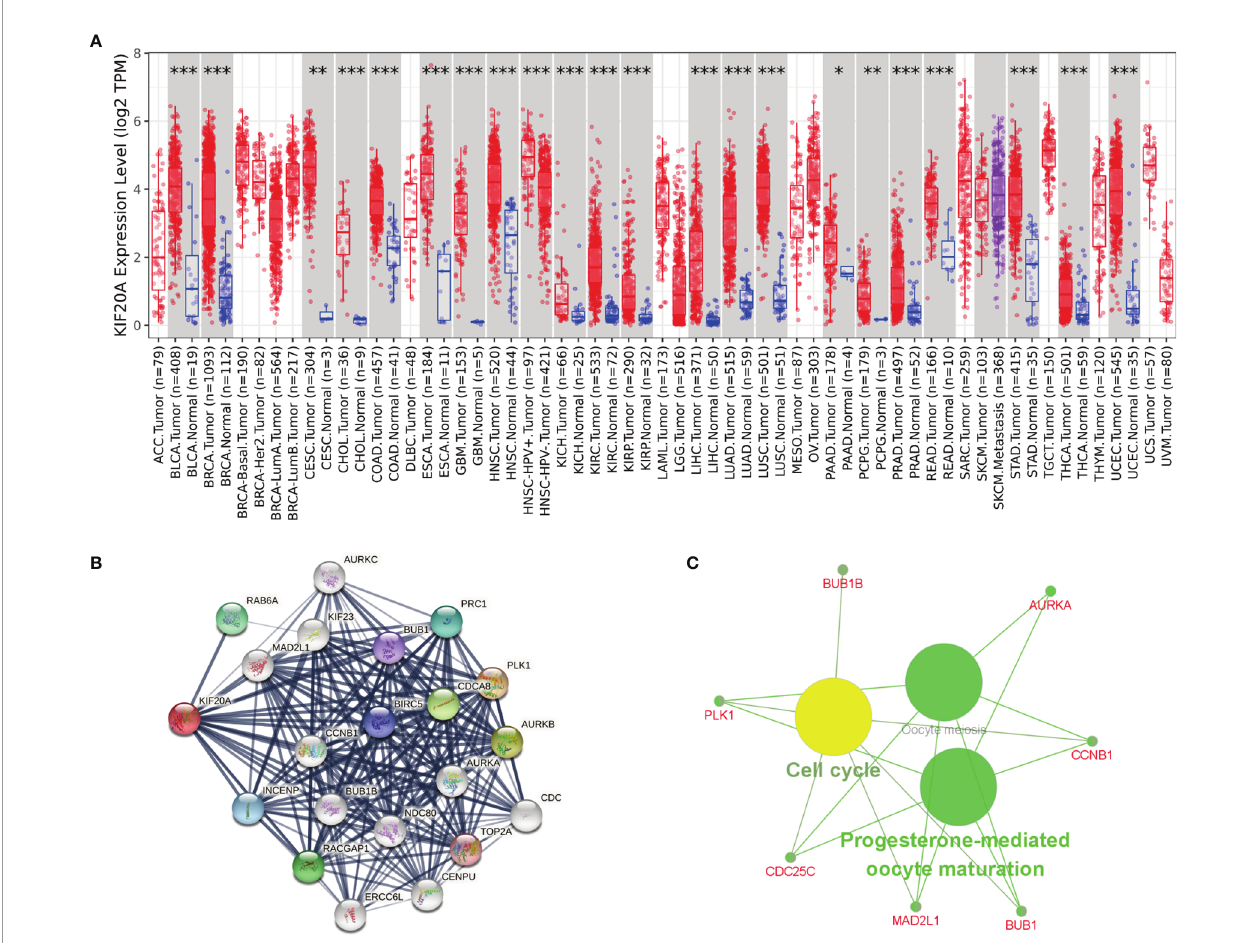
FIGURE 8 | KIF20A ’ s biological involvement in tumors. (A) KIF20A expression in different tumors. (B) KIF20A gene STRING interaction network preview of interacting proteins (showing top 20 STRING interactants). (C) Illustration of KEGG pathway analysis fi ndings using the ClueGO plugin in Cytoscape. *P < 0.05, **P < 0.01, ***P < 0.001.